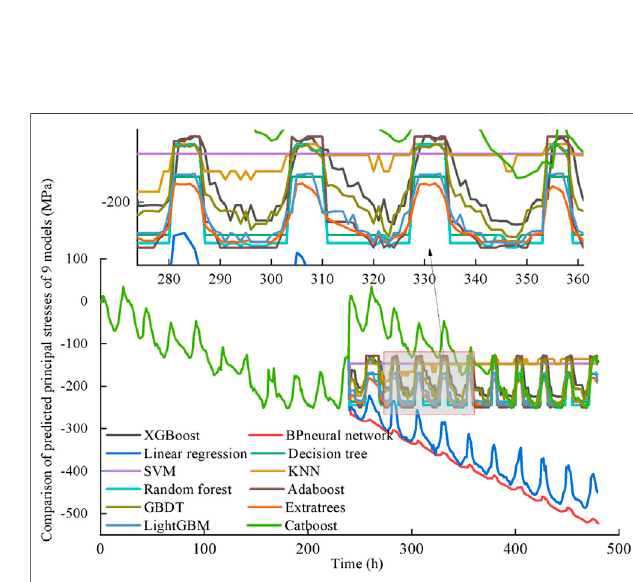
FIGURE 9 | Histogram of evaluation indicators for four machine learning algorithms. FIGURE10| Principal stressevolutionsat thepipeline bottom predicted by 12 ML models, with a partial